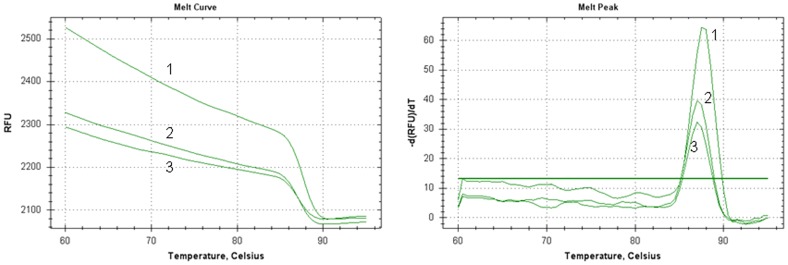
Effects of Cr(VI) and Cr(III) on Tm.The plotted are melting curves of a GAPDH gene fragment in the absence (curves 1) and presence of 150 µM CrO3 (curves 2) or CrCl3 (curves 3).